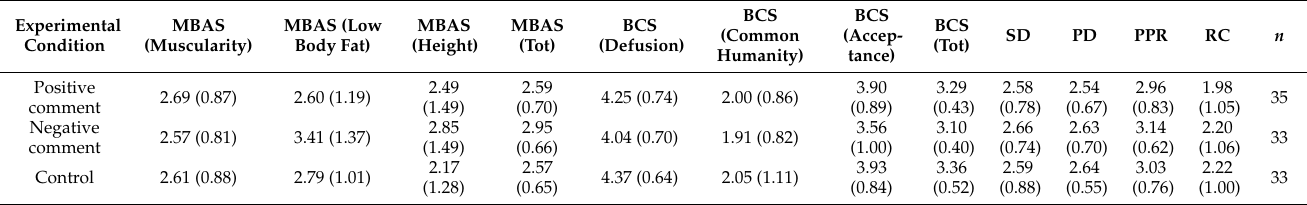
Table 2. Means ( SDs ) of men’s body dissatisfaction, body compassion and, quality of couple relationship by experimental